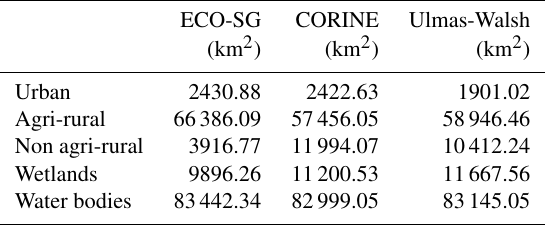
Table B1. Proportion of each of the 5 categories present in ECO-SG, CORINE and the UW map in square kilometres.